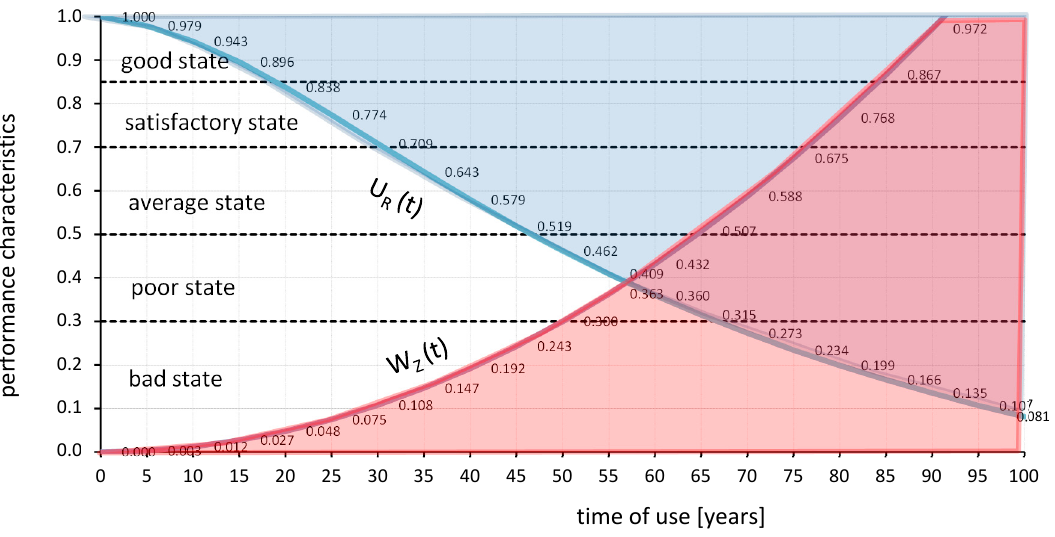
Figure 2. Decrease in use value and wear value of a building over the course of its use.